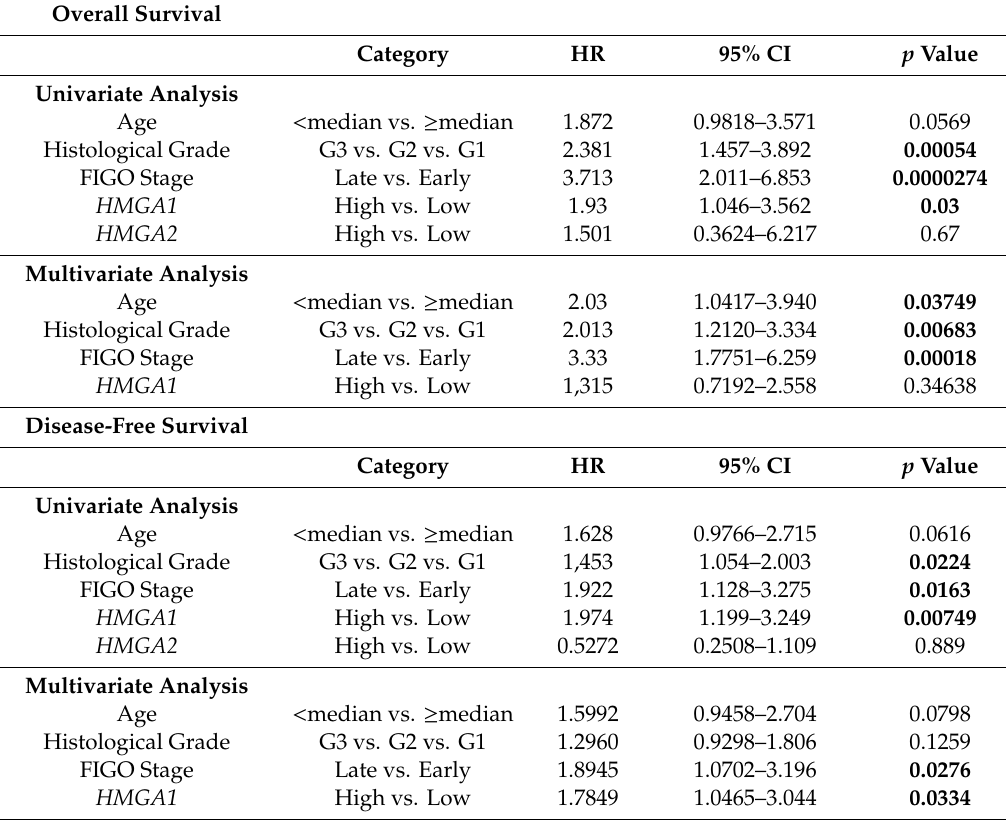
Table 2. Univariate and multivariate overall and disease-free survival analyses of the 381 endometrioid endometrial adenocarcinoma (EEC) patients from The Cancer Genome Atlas (TCGA) database evaluated in the study.